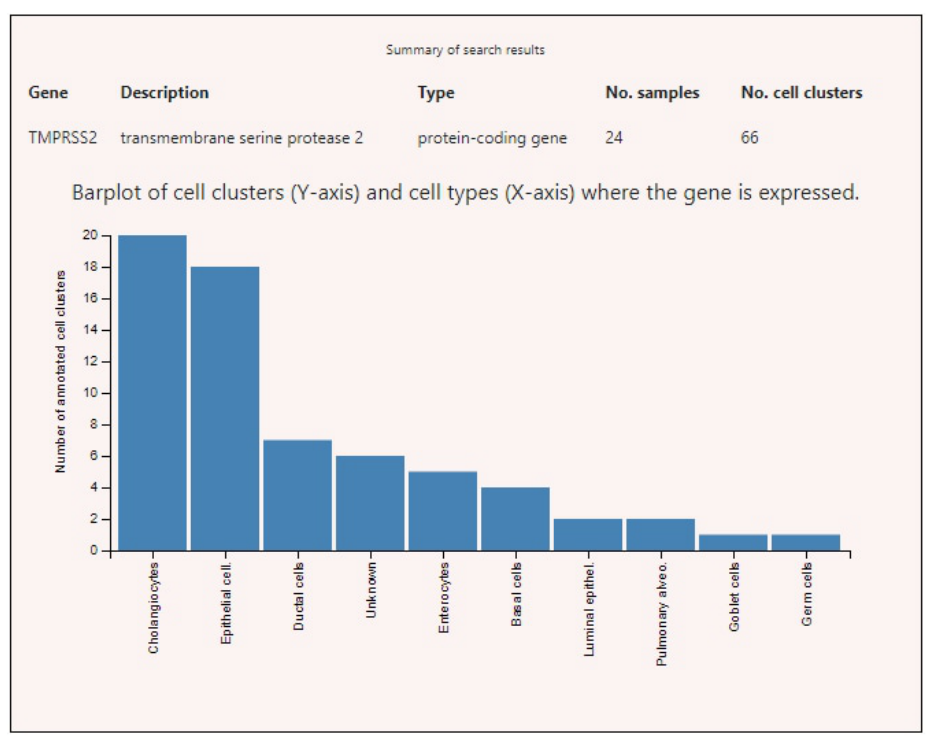
Figure 5. TMPRESS2 expression levels in various human cells.